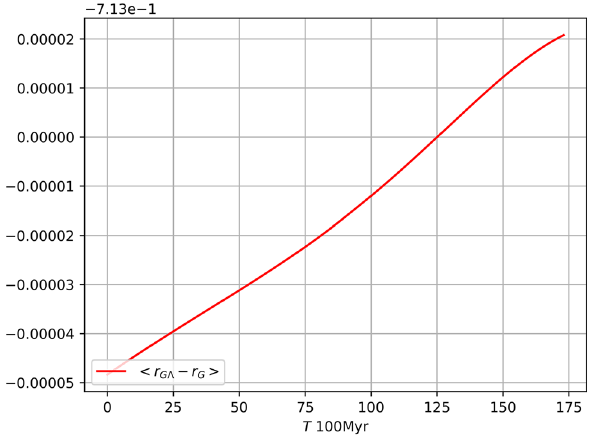
Fig. 4 The same as in Fig. 3 but for R = 18 Mpc